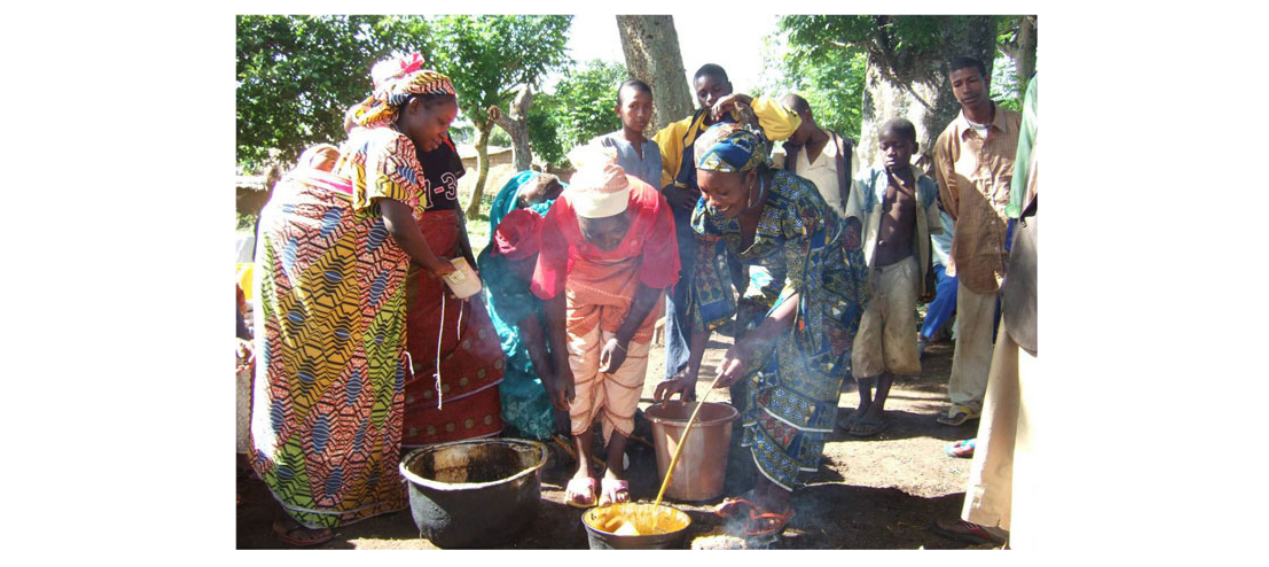
Fig. 4. Women lead soap